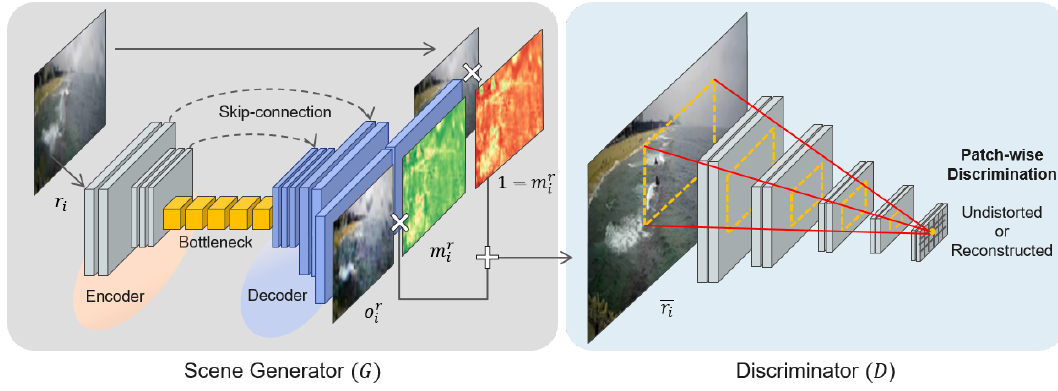
Figure 1. Architecture of the proposed Raindrop-aware GAN